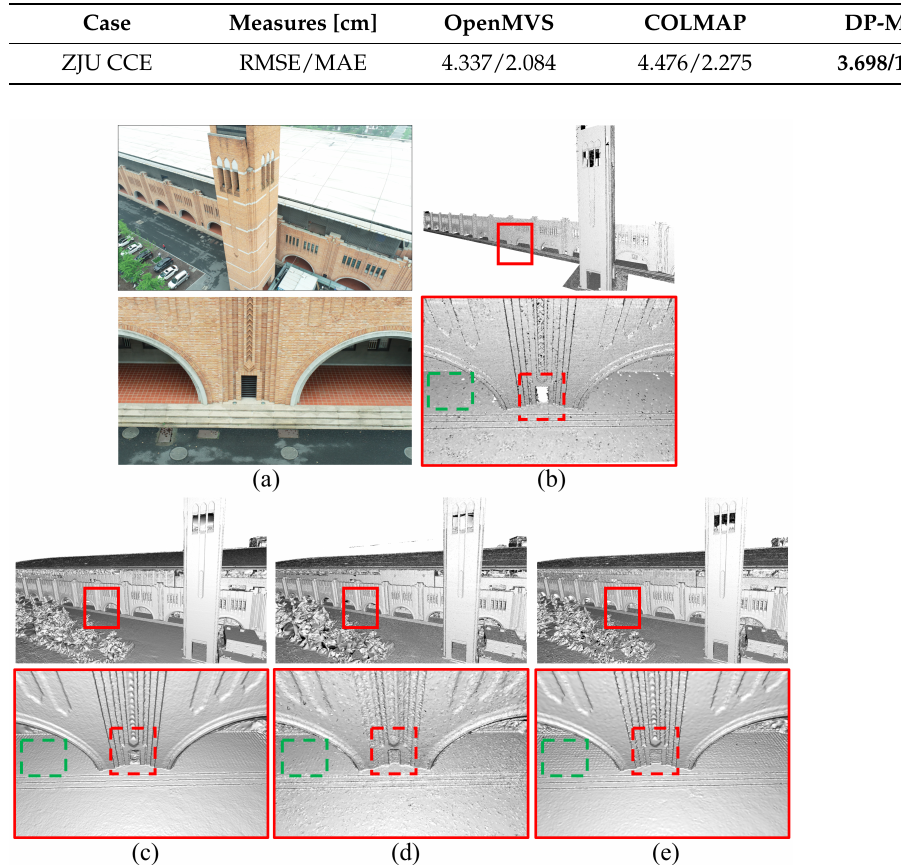
Table 1. The Root Mean Squared Error (RMSE) and Mean Absolute Error (MAE) of the reconstruction results by our system, OpenMVS [56] and COLMAP [26] on the case “ZJU CCE”, whose GT model is used as reference for error computation. We use bold format to highlight the smallest errors among all the methods.